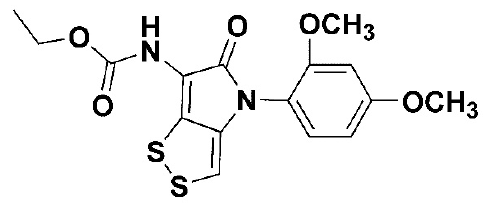
Figure 1. Chemical structure of ZL ‐ 004.